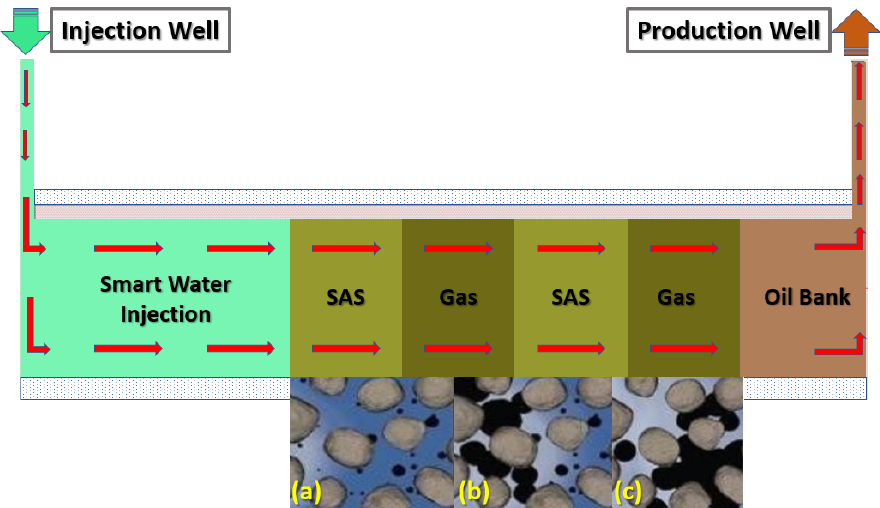
Figure 1. Schematic diagram of SWAF process, which displays the injected scheme scenarios of SWAF method, which starts with smart-water (SW) injection as a secondary mode to change the reservoir wettability (conditioning the reservoir), then the injection of SAG (SAS Alternating Gas) i.e., SAS followed by gas injection (i.e., CO 2 and N 2 ) slugs injections as a tertiary mode or stage. ( a ) Injection of SWAF solution in presence of crude oil, ( b ) SWAF solution interacts with crude oil, and ( c ) oil detaches from rock and moves toward production